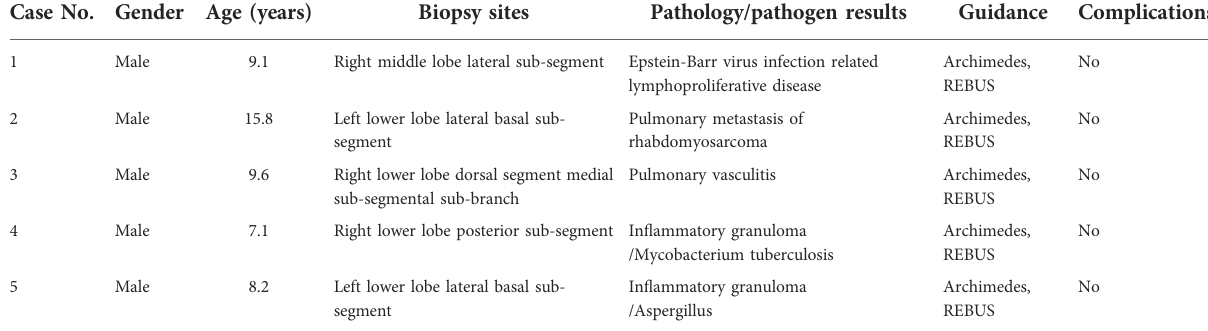
TABLE 1 Clinical data of children who underwent archimedes virtual bronchoscopic navigation-guided lung biopsy. Case No. Gender Age